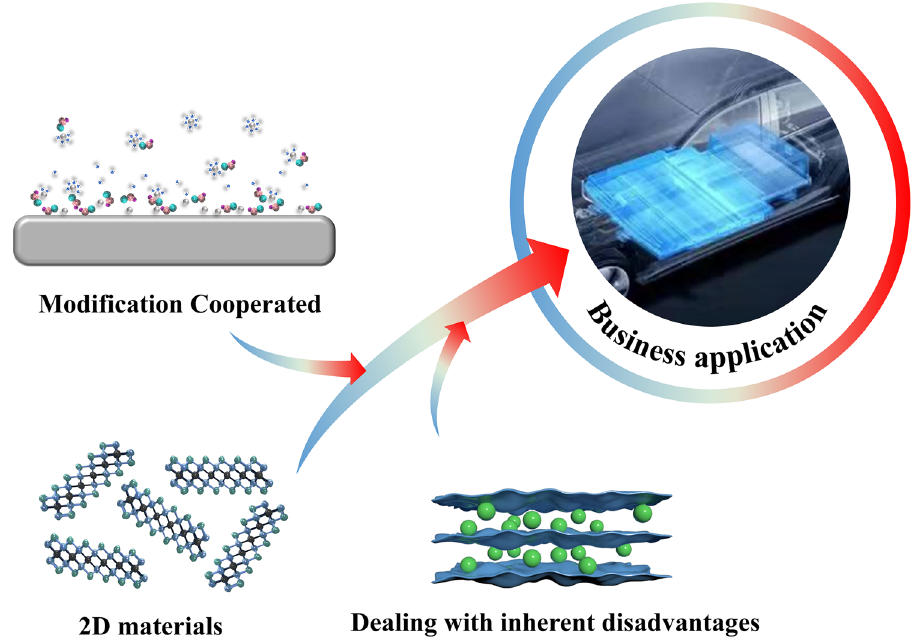
Fig. 8 Discovery, evolution, and application of 2D materials in Zn anodes of